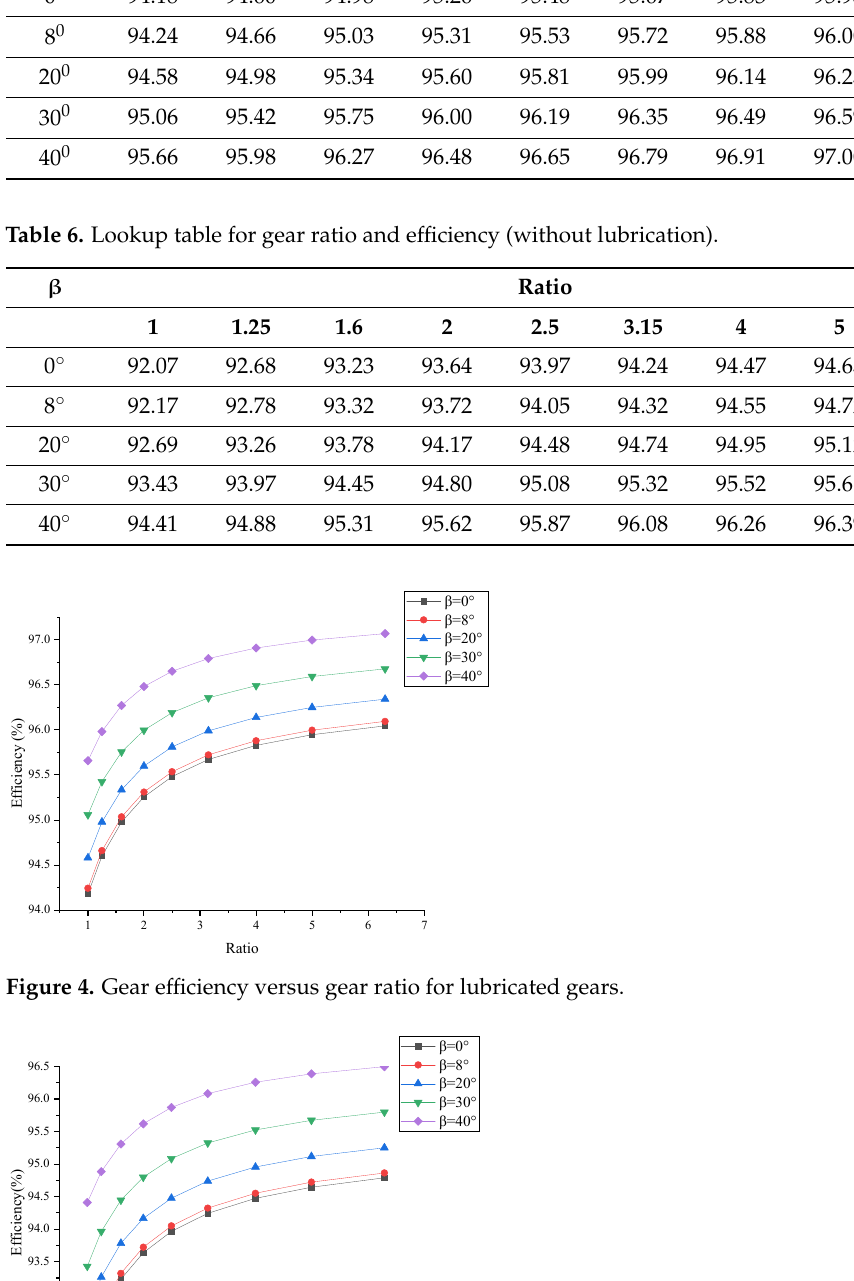
Figure 5. Gear efficiency versus gear ratio for non-lubricated gears. Through the design of the experiment and optimization, we can determine the opti- mal set of parameters and their influences on gear efficiency. The goal of the PBD experi- ment was to establish which factors have the most influence on gear efficiency. The most important factors would then be investigated further using response-surface methods,